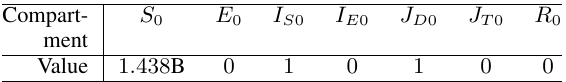
Table III: Initial conditions on 8 December 2019 (B stands for billion). Compart-